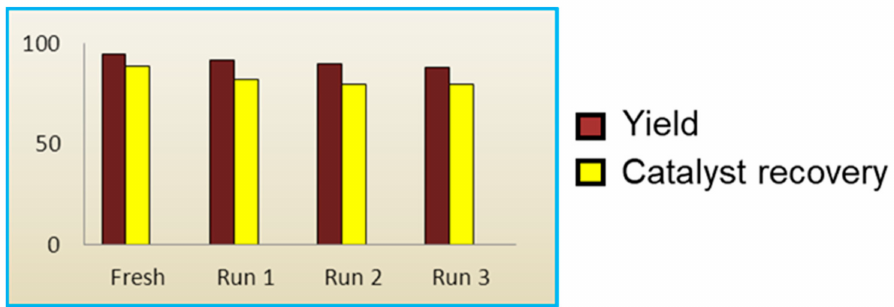
Figure 2. Reuse and recovery of bleaching earth clay and its effect on